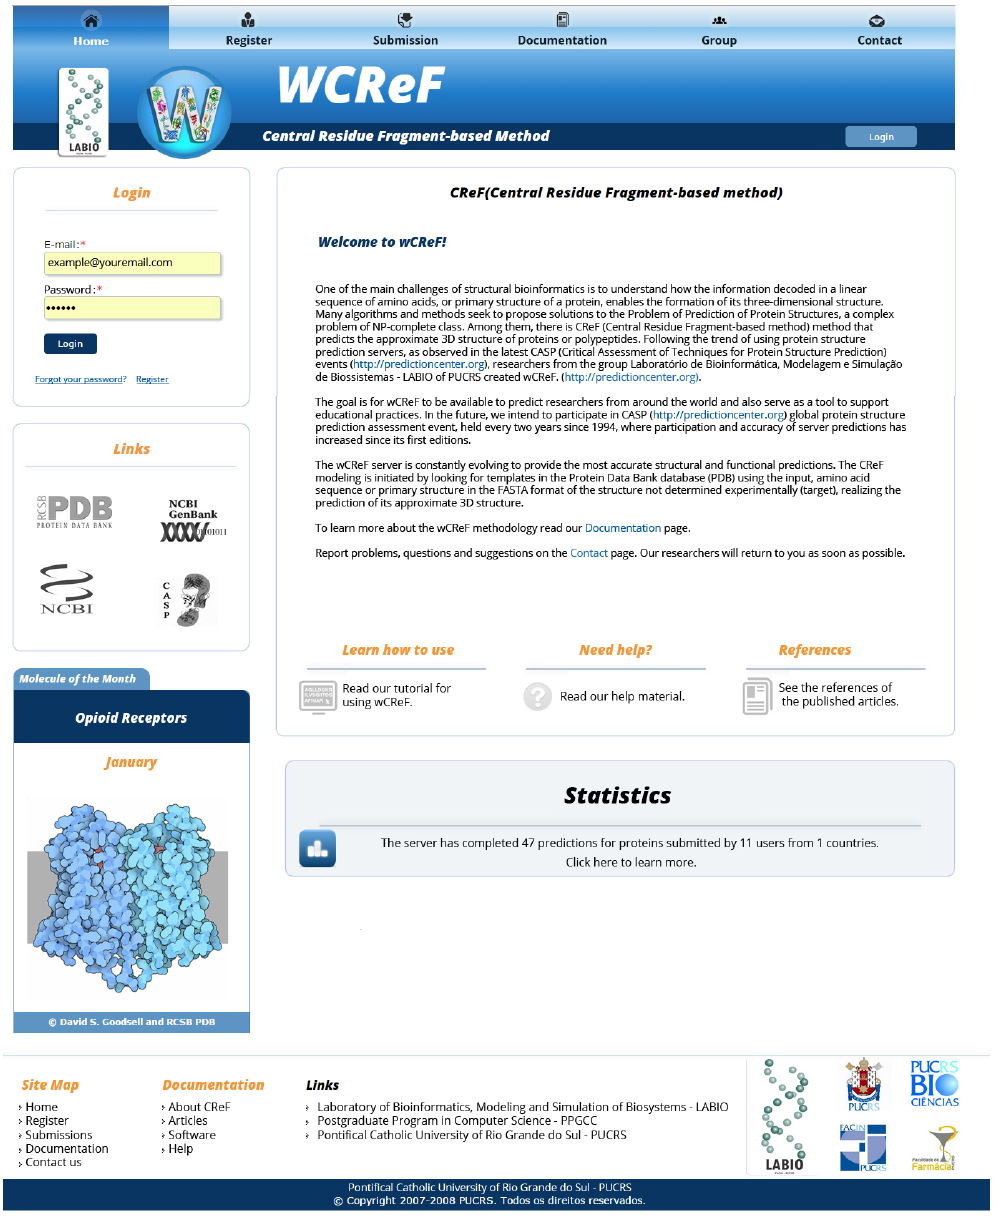
Figure 6. wCReF homepage with log-in area, server usage information, statistics and links to additional resources (all the figures of the article show the content in Portuguese. The wCReF website is being updated to support multiple